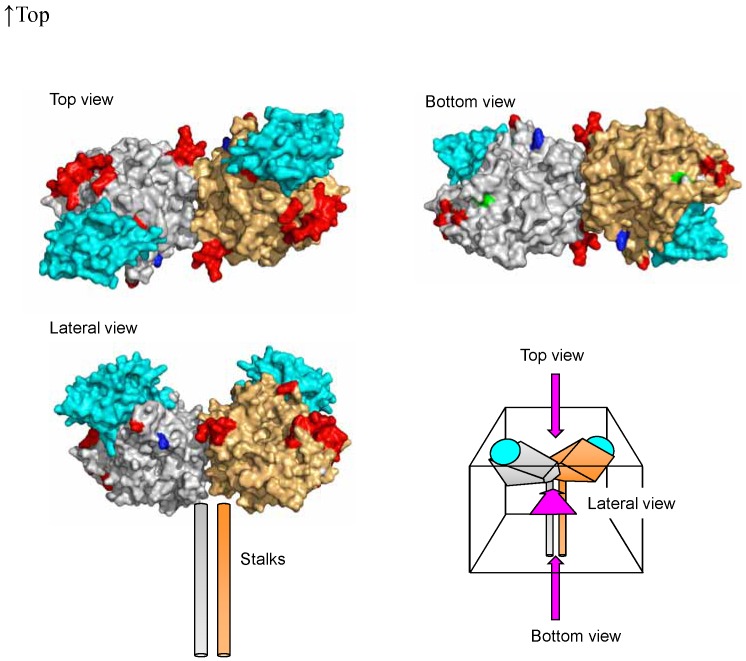
The predicted structure of H protein in MeV.The H head dimers are shown from the top, bottom, and lateral angles. Each monomer is shown in gray or orange. Residues reported to constitute epitopes are shown in red. SLAM is shown in cyan. Positively selected amino acid sites, 476 and 575, are shown in light green and blue, respectively.